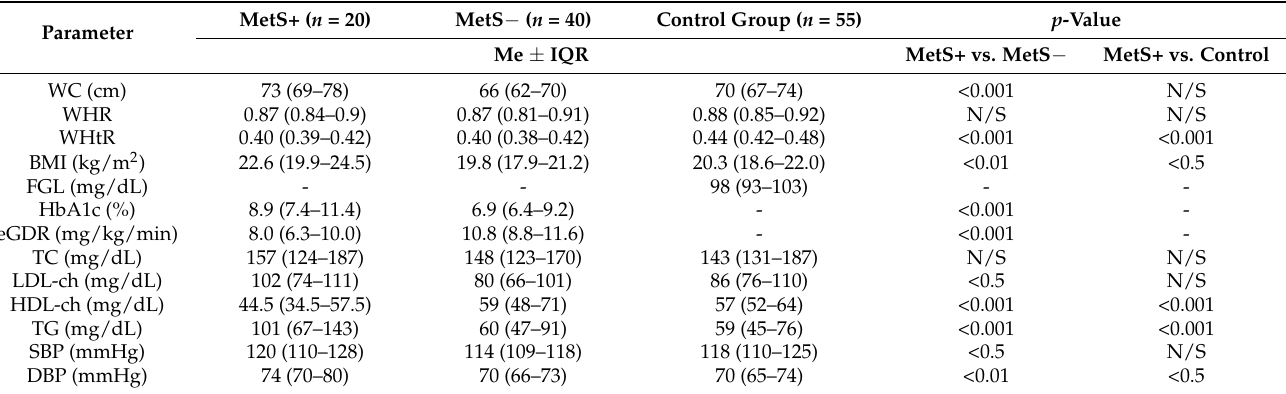
Table 4. Comparison of cardiovascular